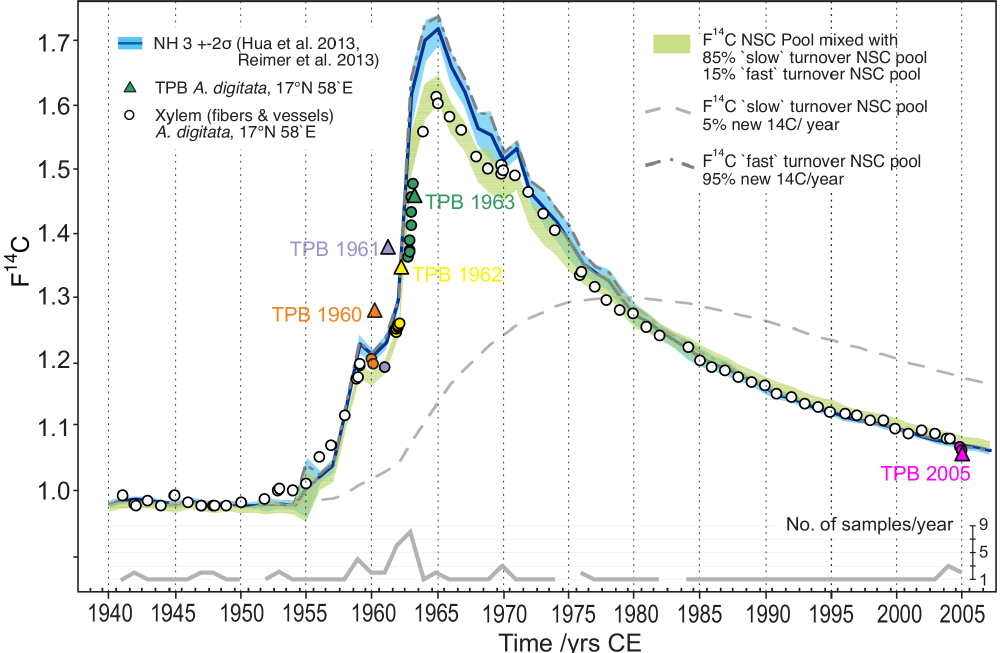
Figure 8. Baobab F 14 C values in comparison with the F 14 C curve for NH 3 (blue line/shade) and modeled pools of non-structural carbohy- drates (NSCs) fueling wood formation. The observed F 14 C values of baobab xylem fibers and vessels (circles) are well approximated by as- suming polymerization from a mixed NSC pool (F 14 C NSCm [ i ] ) with contributions from a fast (F 14 C NSCf [ i ] ) and slow (F 14 C NSCs [ i ] ) turnover NSC pool, respectively. Range of F 14 C NSCm [ i ] (green shade) is given by the 2 σ range of atmospheric F 14 C source values (F 14 C NH each year ( [ i ] ). 1940 was chosen as the starting year for the model calculations. Terminal parenchyma bands (TPB, colored triangles) show higher (1960–1962) and lower (2005) F 14 C values than F 14 C of NH 3 and xylem fiber and vessel tissue of corresponding tree rings. This indicates distinct younger ages of TPBs and points to structural changes and ongoing cell division of parenchyma tissue for a number of years after initial formation. Some F 14 C values of fiber and vessel samples (e.g., 1945, 1953, 1954, 1957, 1958) were also found above corresponding NH 3 values. This might allude to the presence of intraxylary parenchyma tissue that could not be detected during the tree-ring dissection